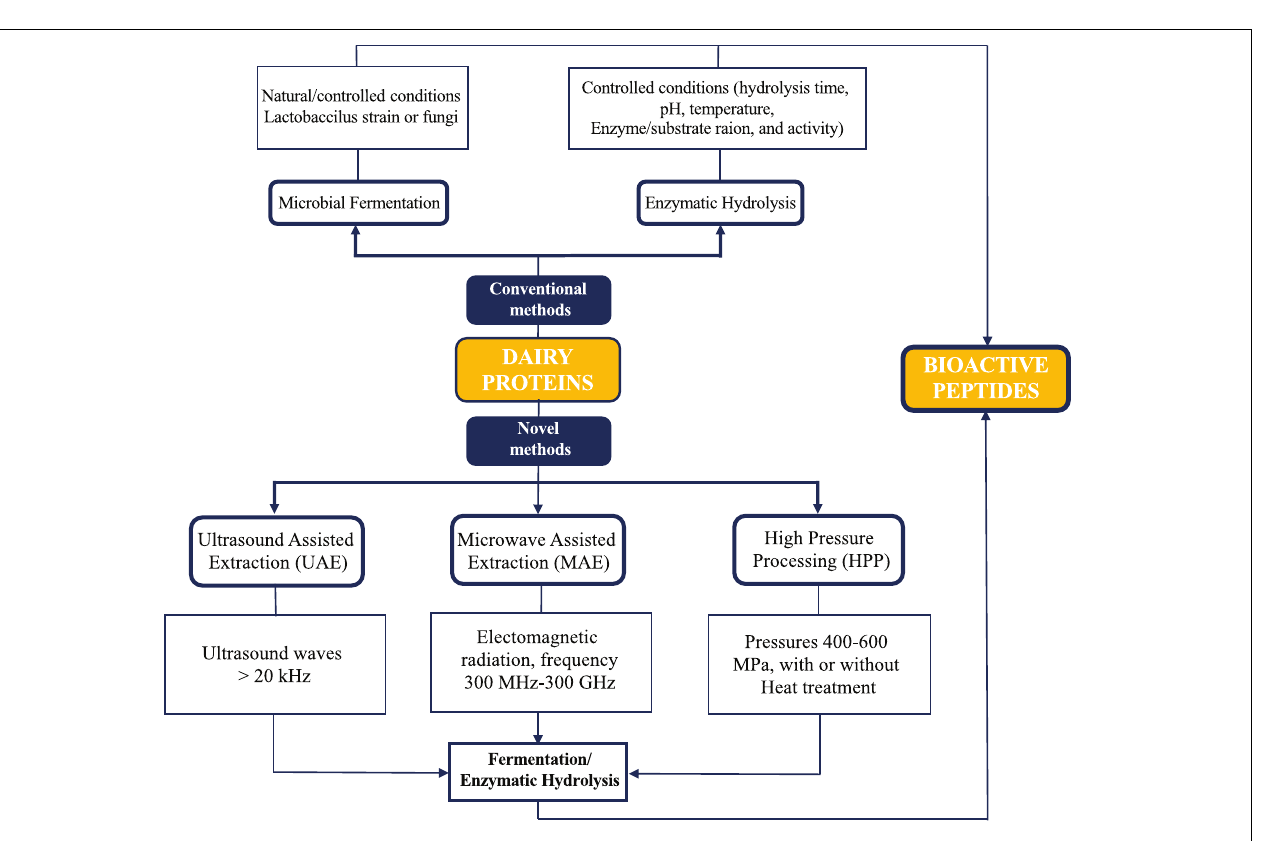
Frontiers in Nutrition |